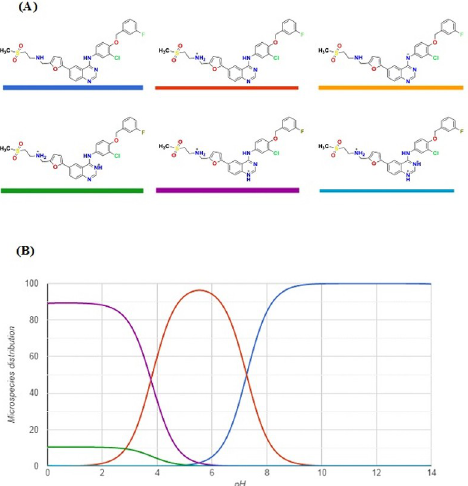
Fig 7. Theoretical protonation states of LAP as a function of the pH. Panel (A): the chemical structures of the different protonated states of LAP. Panel (B): Microspecies distribution of LAP according to the pH value. The colors of the curves match with those of the chemical